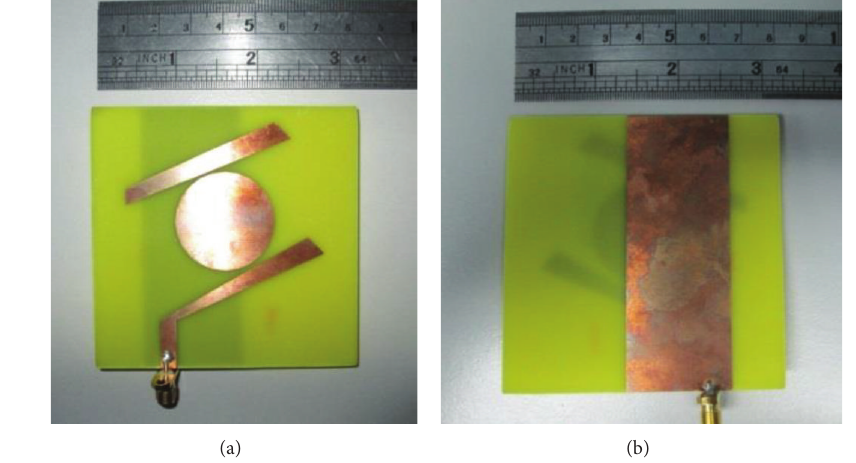
Figure 2: (a) Patch and (b) ground plane of the fabricated antenna prototype.